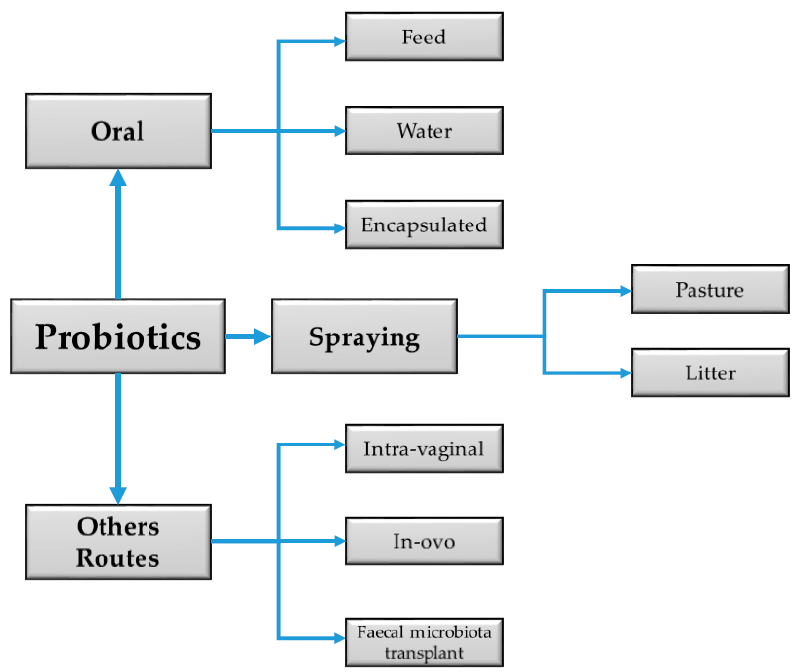
Figure 1. Diagram summarizing the common routes of administering probiotics in